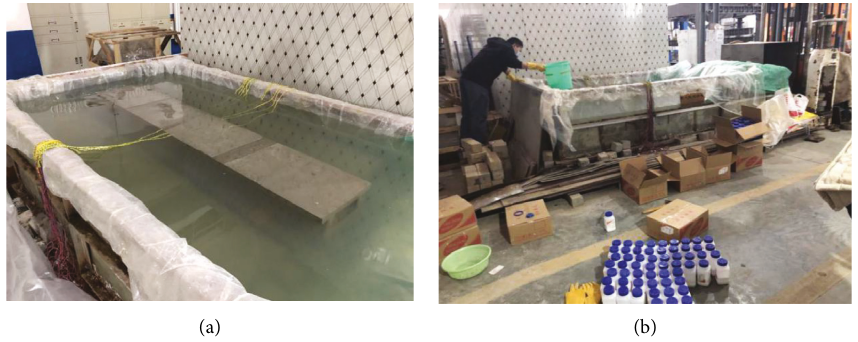
Figure 3: Immersion test of the model beam. (a) Immersion model beam. (b) 10% Na